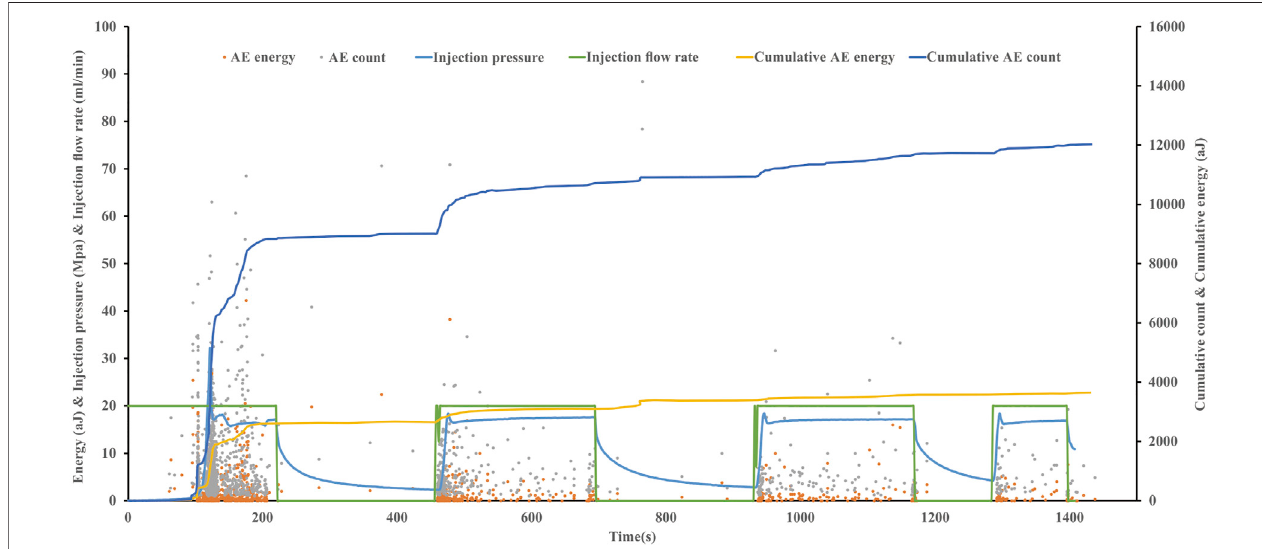
FIGURE 5 | Result of the injection pressure and AE energy and count of HDR400-2.